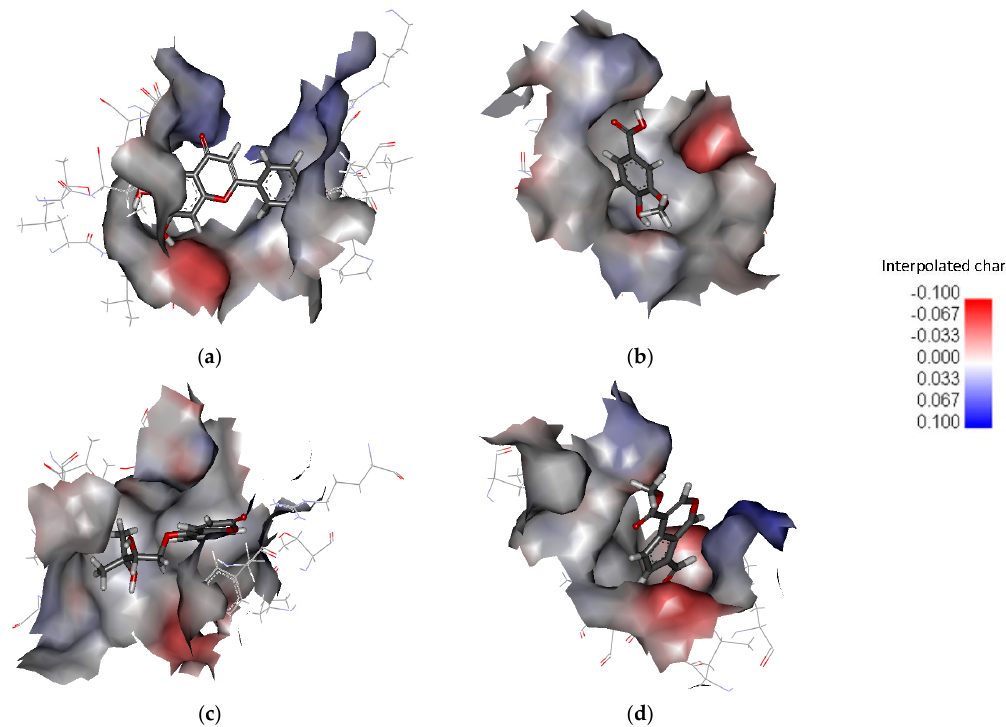
Figure 6. Interpolated charge surfaces around ( a ) PHF; ( b ) HMB; ( c ) DHMBP; and ( d ) cerbinal molecule.